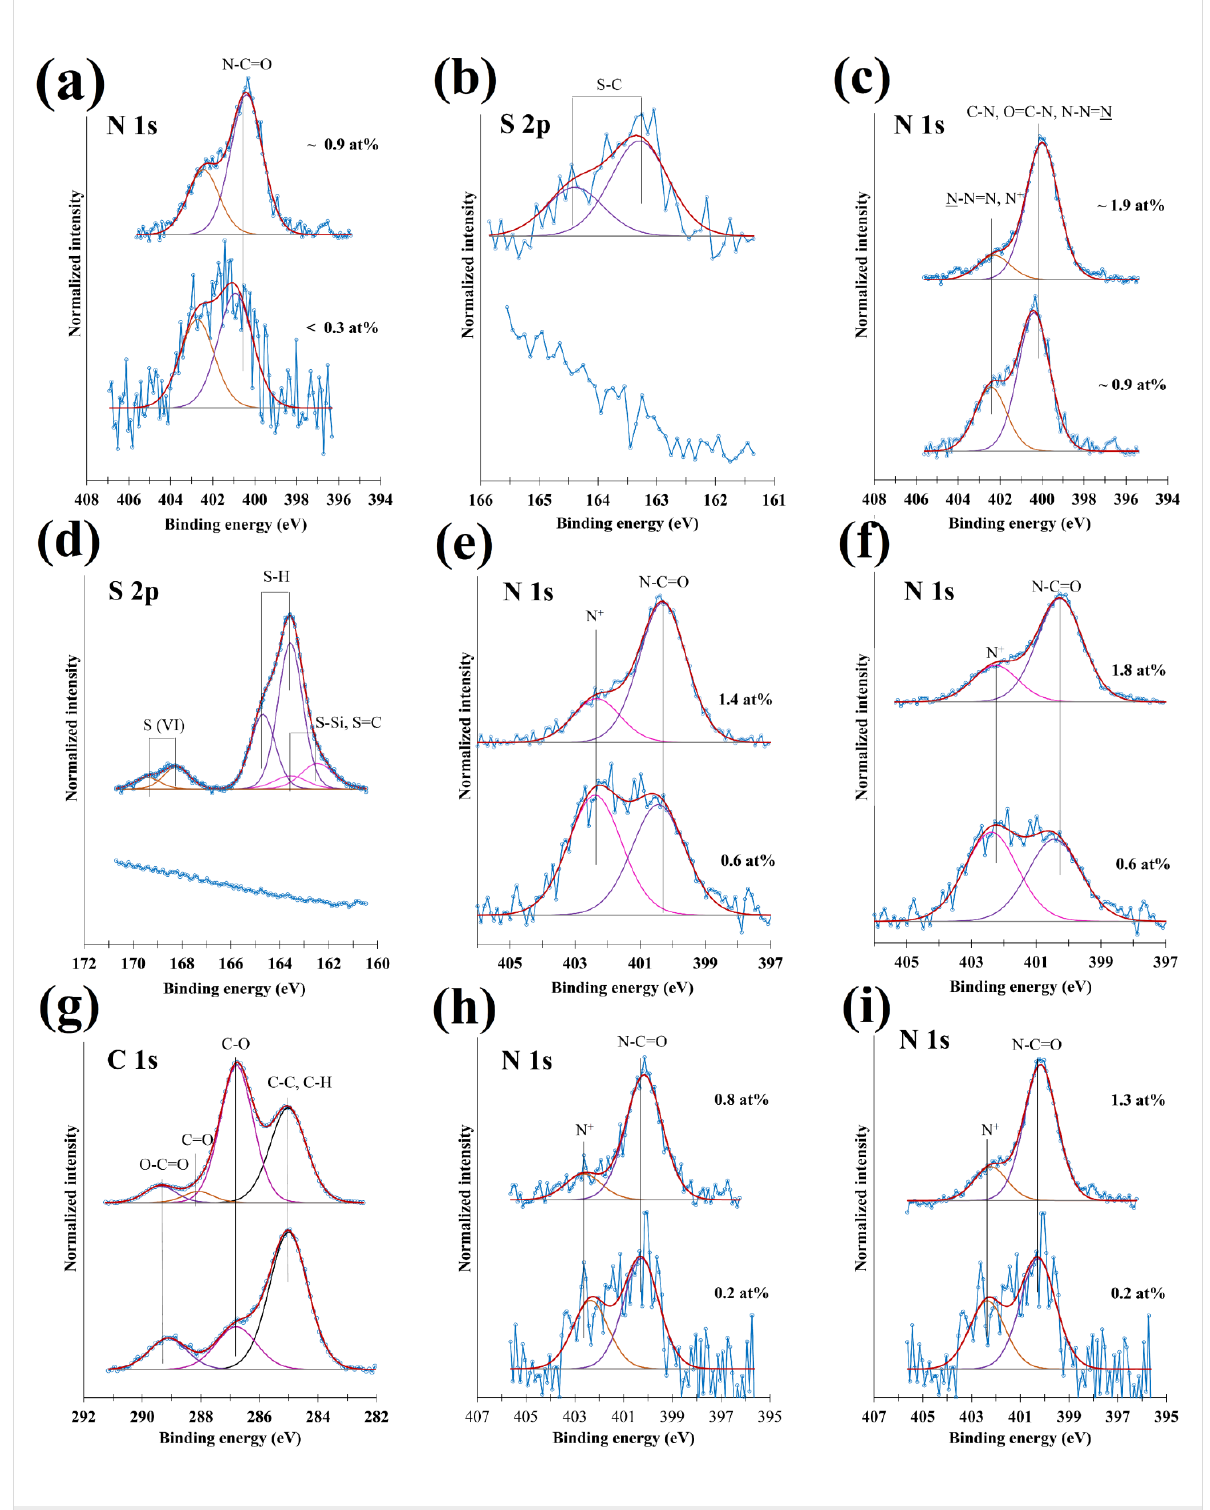
Figure 2: XPS characterization of a) the hydroxy-terminated (bottom) and the DBCO-terminated (top) glasses, b) the DBCO-terminated glass (bottom) and the sample of route 1 (top), c) the DBCO-terminated glass (bottom) and the sample of route 2 (top), d) the hydroxy-terminated (bottom) and the thiol-terminated (top) glasses, e) the thiol-terminated glass (bottom) and the sample of route 3 (top), f) the thiol-terminated glass (bottom) and the sample of route 4 (top), g) the hydroxy-terminated (bottom) and the epoxy-terminated (top) glasses, h) the epoxy-terminated glass (bottom) and the sample of route 5 (top), i) the epoxy-terminated glass (bottom) and the sample of route 6